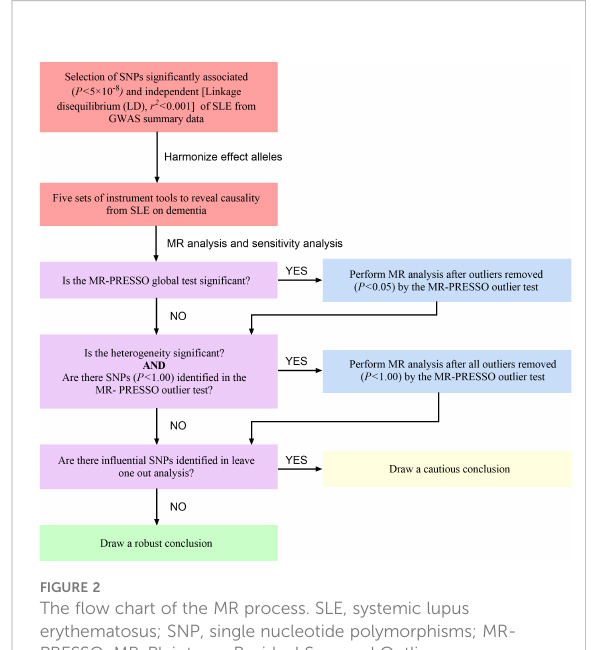
FIGURE 2 The fl ow chart of the MR process. SLE, systemic lupus erythematosus; SNP, single nucleotide polymorphisms; MR- PRESSO, MR-Pleiotropy Residual Sum and